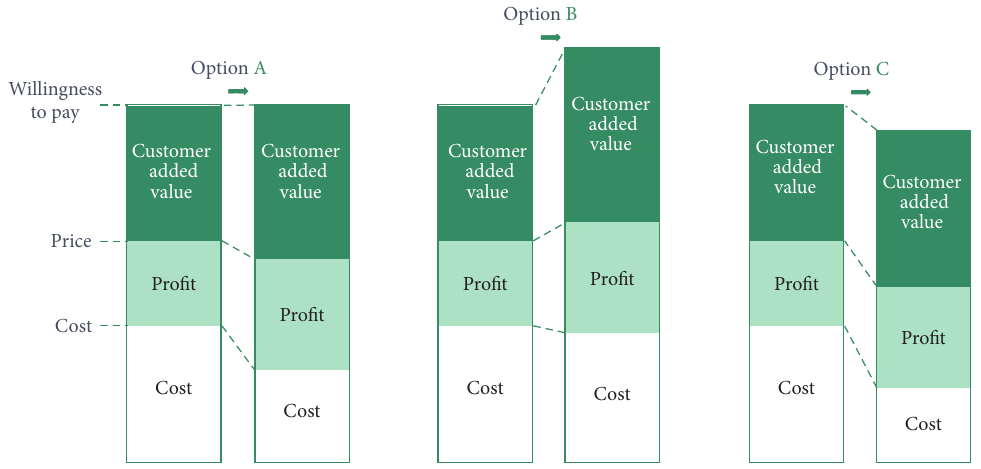
Figure 3: Common design options to achieve business model innovations